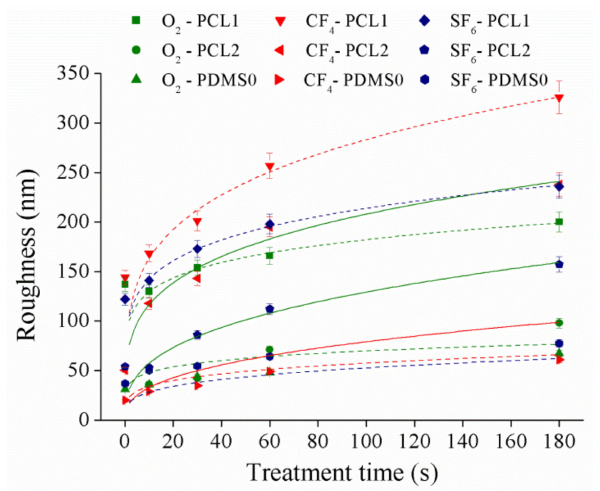
Figure 3. The surface roughness of PCL and PDMS films at 30